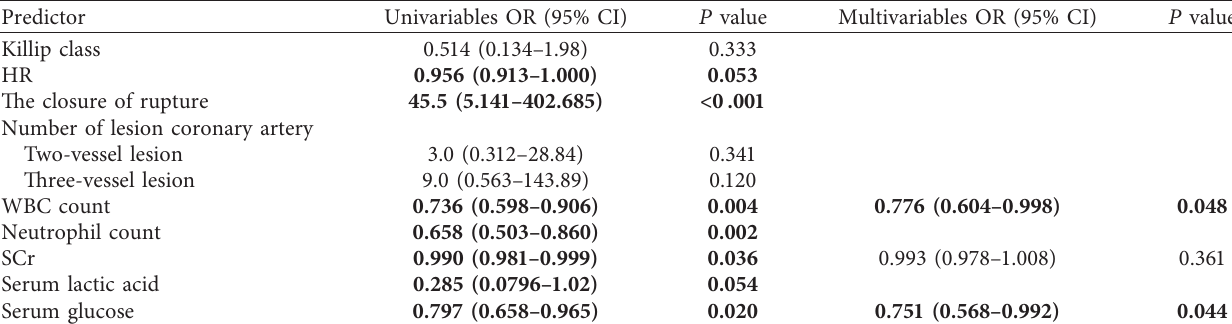
Table 4: Univariable and multivariables analysis predicating survival in hospital.